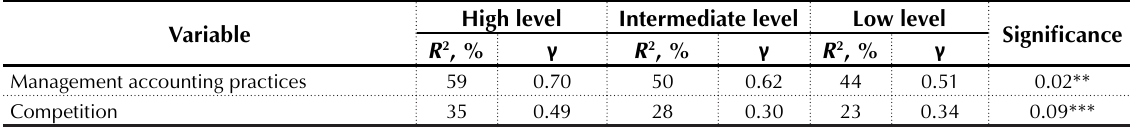
Table 5. Changes in company strategies according to the level of adaptation to management